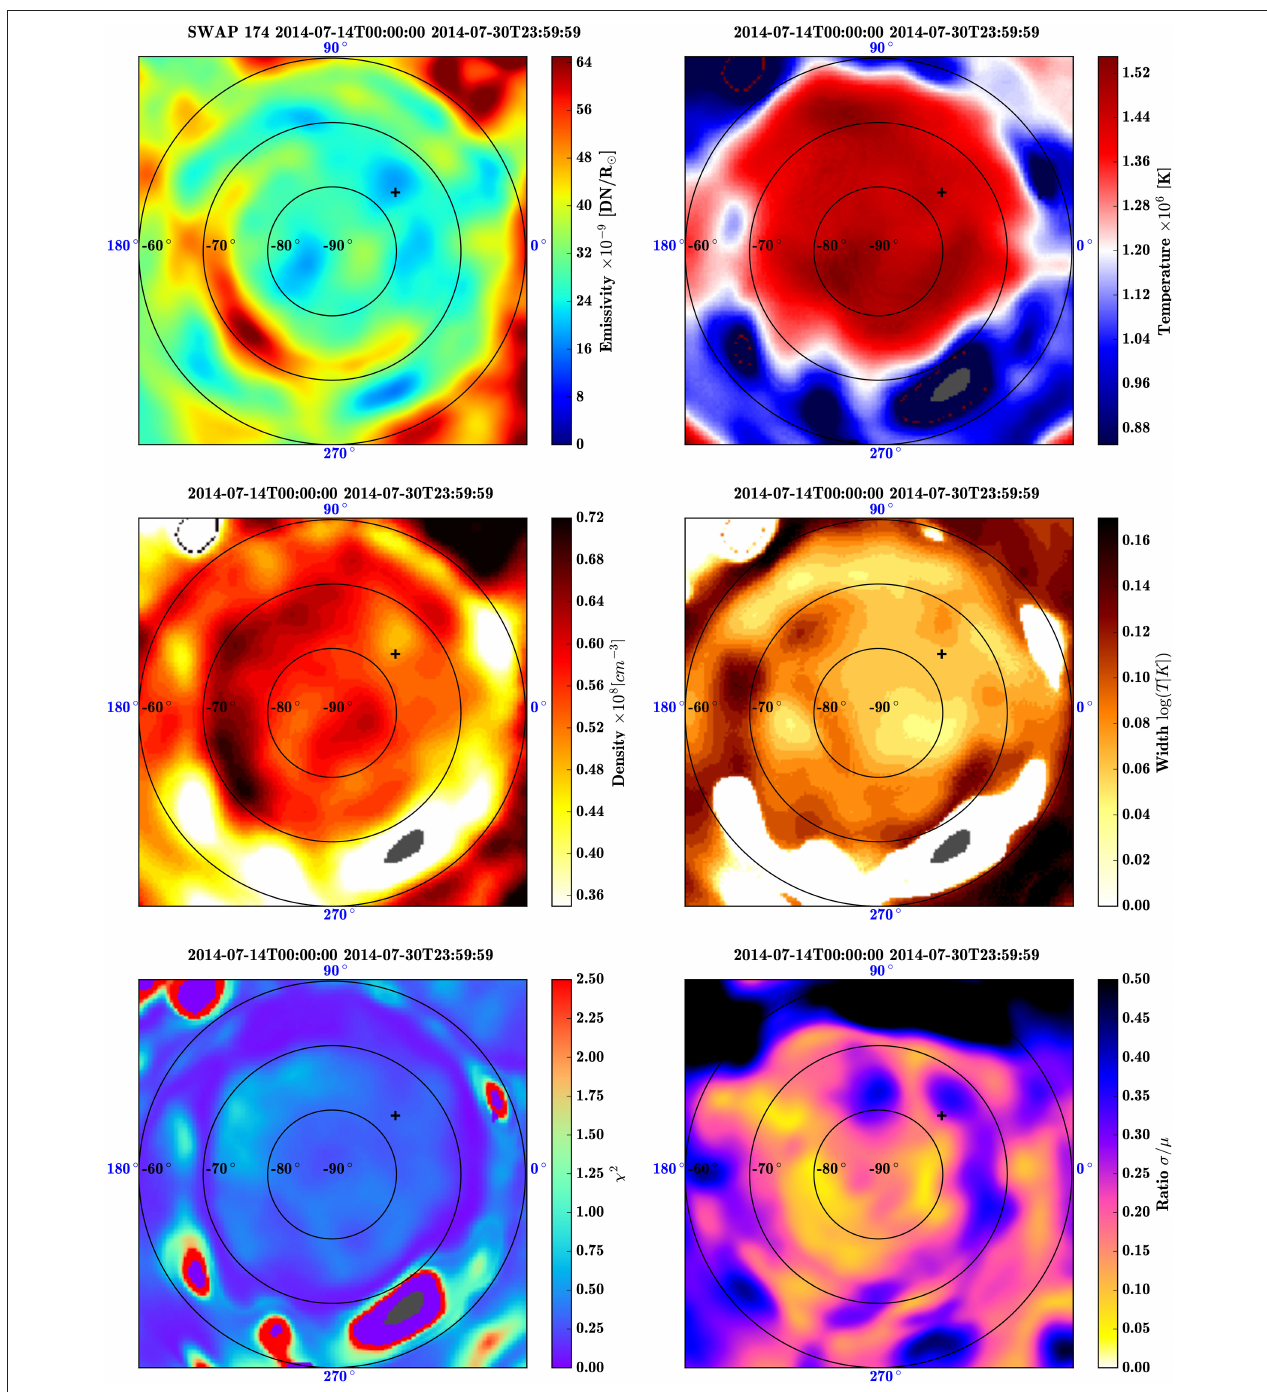
FIGURE 8 | Same as Figure 7 but for an altitude of 1.10 R ⊙ . Note that the position of the cavity center reported here (black plus sign) was measured at 1.05 R